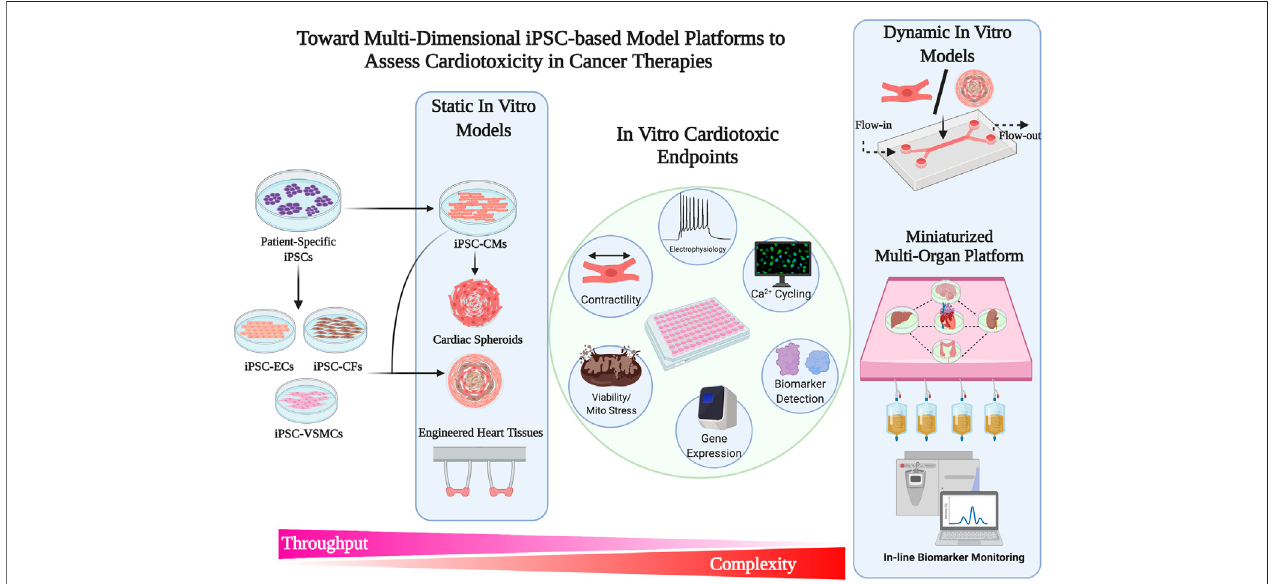
FIGURE 2 | Toward multi-dimensional iPSC-based model platform to access Cardiotoxicity in Cancer therapies.